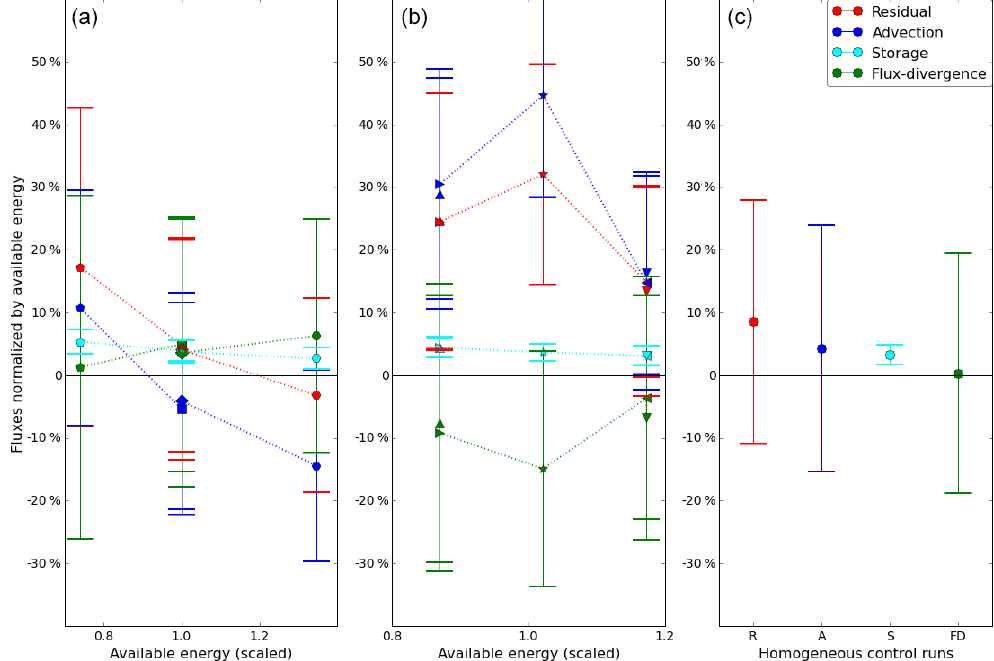
Figure 4. Control volume fluxes as a function of available energy (scaled by the median value) for kilometer scale landscape heterogeneity. The fluxes are normalized by the available energy at their respective location, in our setup this means normalization by the surface flux. Please note that we have plotted the non-closure (normalized energy balance residual) instead of the energy balance ratio EBR (normalized turbulent flux). Panel (a) shows the towers at the centers of the patches, Panel (b) the towers at the edges of the patches and Panel (c) the results for the homogeneous control runs. For the tower symbols, see Fig. 1. The error bars denote the spread over the different cases of surface heterogeneity within the suite of kilometer scale surface heterogeneity. The abscissa is the available energy at the tower but scaled by the mean available energy of the nine towers for that case. In this way, we can group the towers by tower type for the cases with different surface amplitudes. Thus, the low values represent the towers located at the cooler patches (downdrafts), the high values the towers located at the hotter patches (updrafts). See text for further